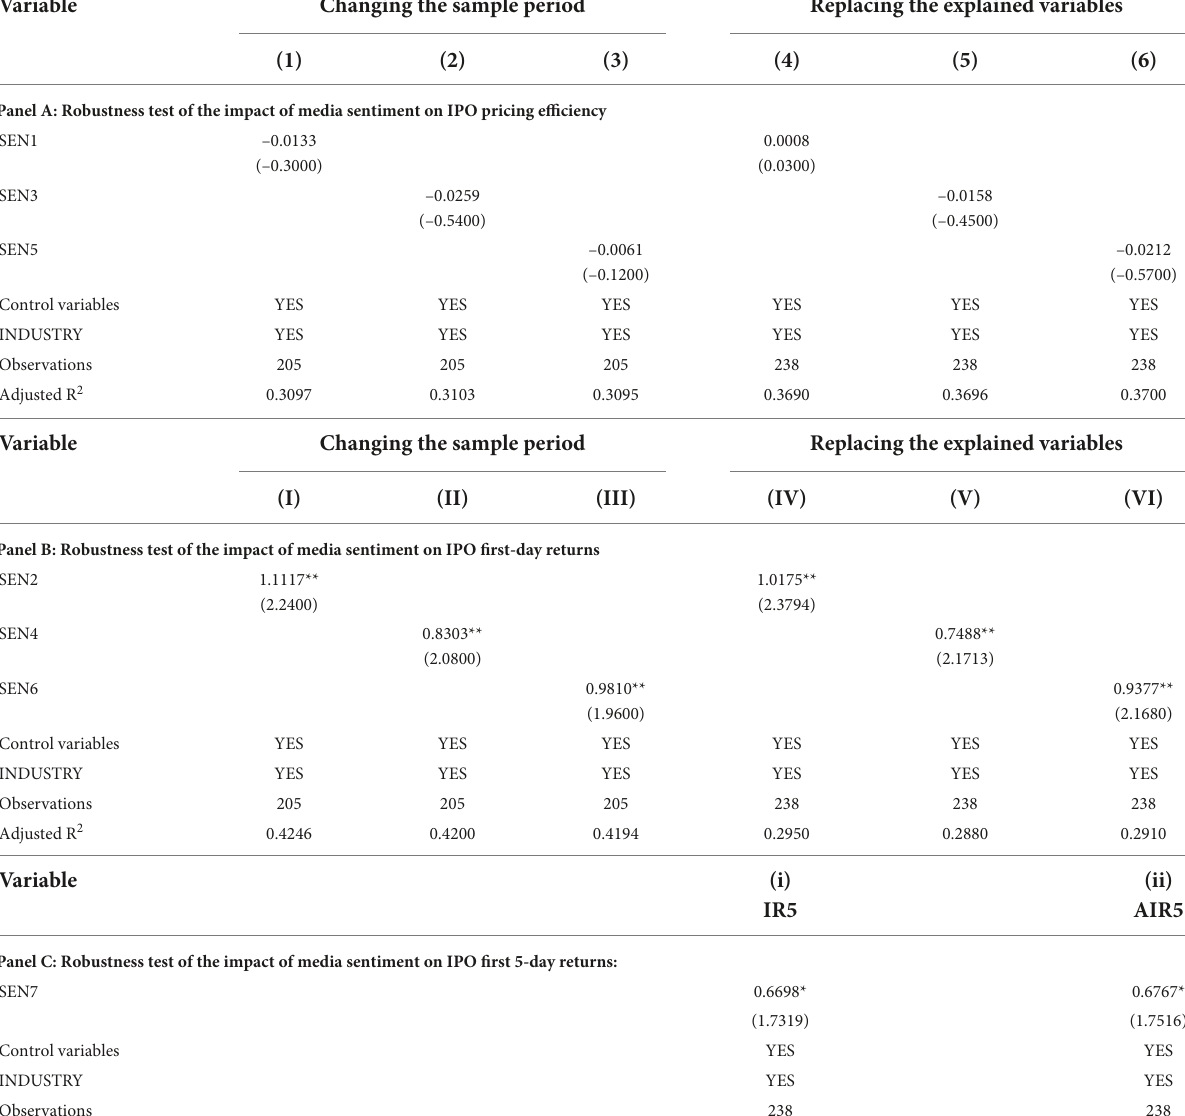
TABLE 6 Results of robustness